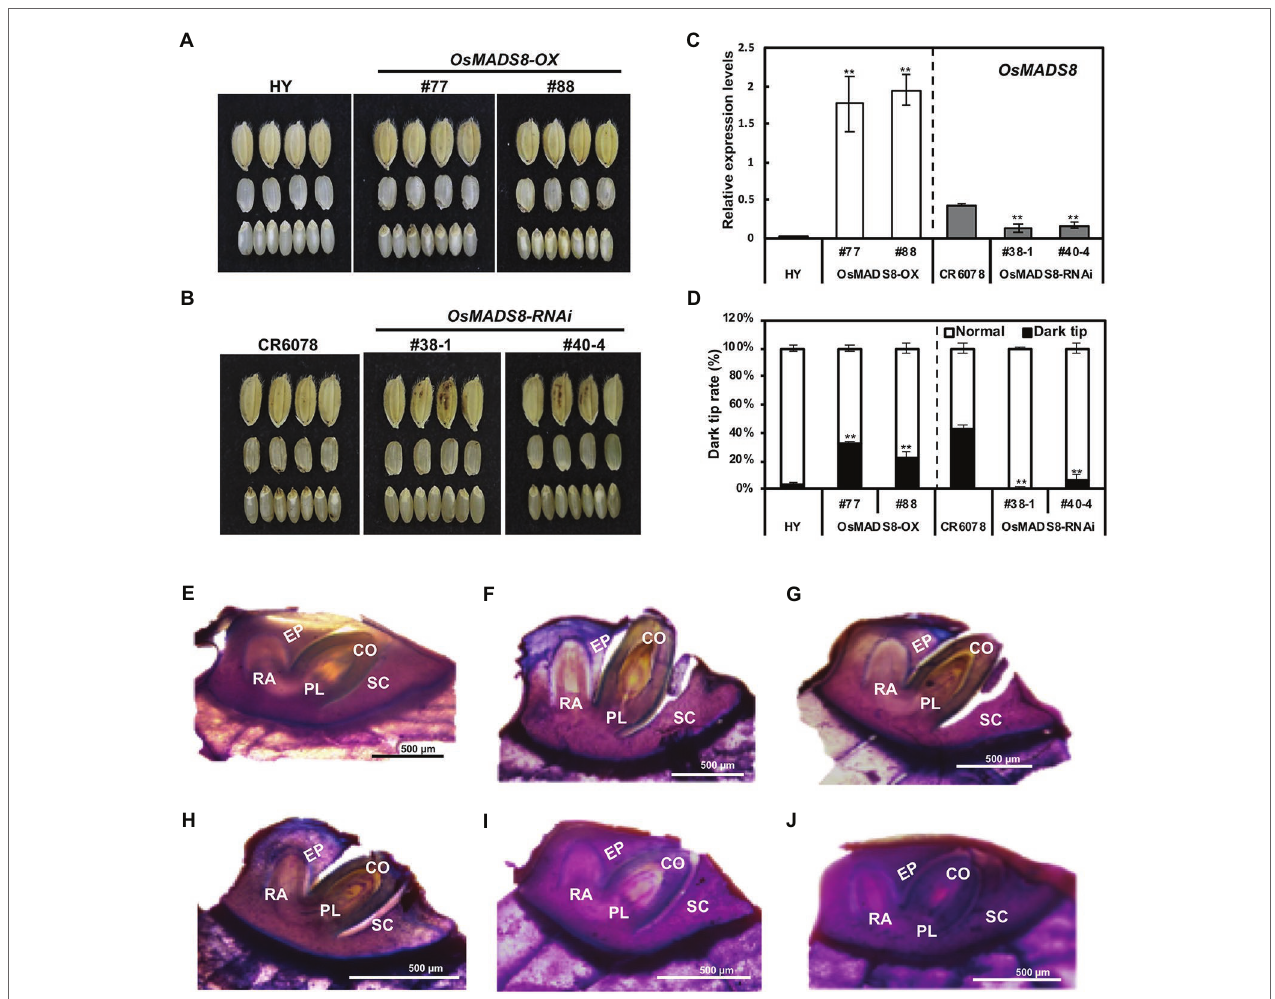
FIGURE 3 | Characterization of the OsMADS8 transgenic lines. (A) Comparison of the grain between HY and OsMADS8 -OX (#77, #88) lines. (B) Comparison of the grain between CR6078 and OsMADS8 -RNAi (#38–1, #40–4) lines. (C) The expression level of the OsMADS8 gene in the transgenic plants. (D) Dark tip embryo rate (%). Histological analysis of the embryo shape of HY (E) and two OX lines (F,G) and CR6078 (H) and OsMADS8 -RNAi lines (I,J) . SC, scutellum; CO, coleoptile; PL, plumule; EP, epiblast; and RA, radicle. ** indicates significant difference based on the student’s t -test at p <